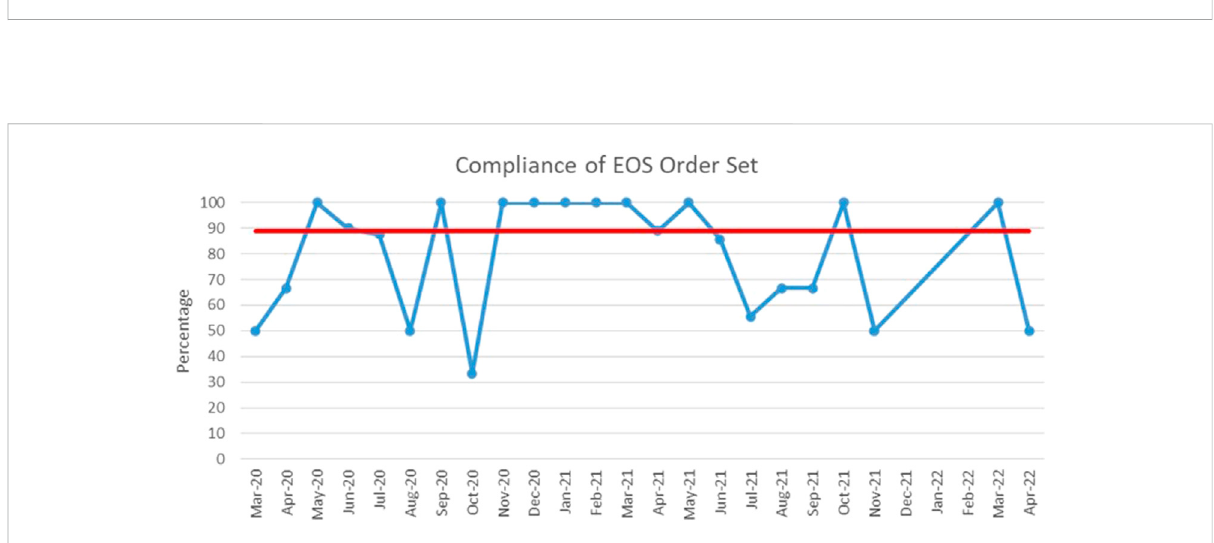
FIGURE 4 Runchartplottingtheusageofthe48-hhardstopordersetfromMarch2020tillApril2022.Redline:median.Blueline:percentageoforderset use in case of suspected early onset